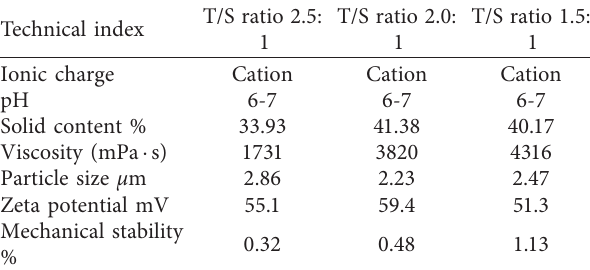
Table 6: Performance specifications of concentrated SBS